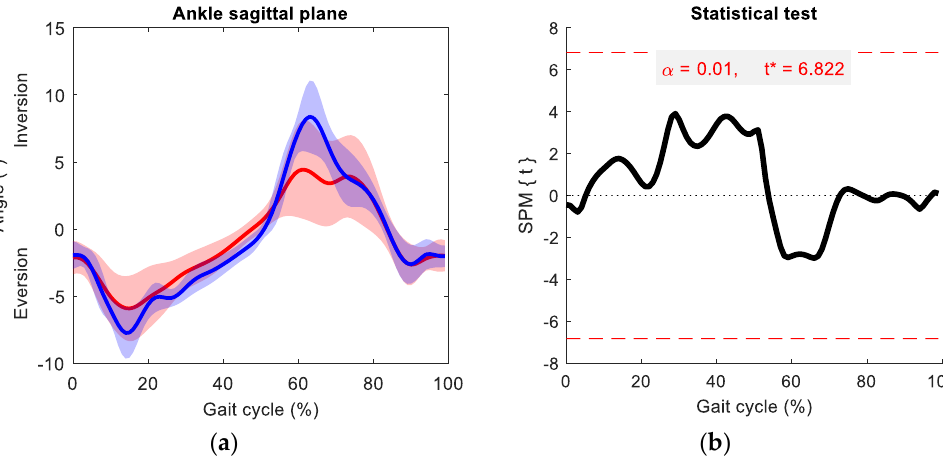
Figure 7. ( a ) Mean frontal ankle angle during gait cycle from heel strike to heel strike with (red) and without (blue) exosuit, and ( b ) statistical 1D SPM test; * critical t-value.